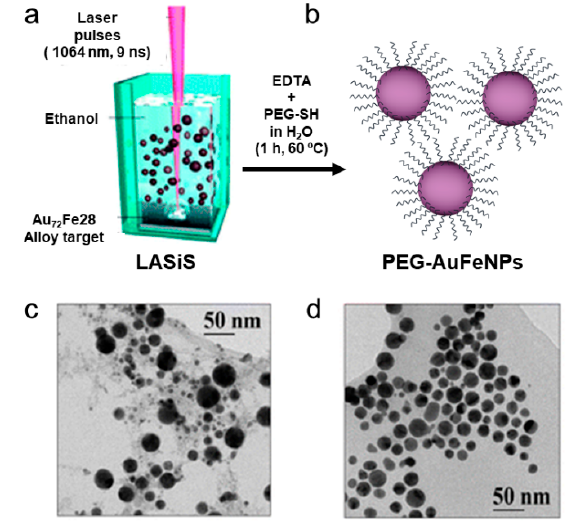
Figure 8. Two-step synthesis of PEG–AuFe NPs. ( a ) LASiS was used to synthesize AuFeNPs in ethanol from a bulk Au 72 Fe 28 alloy. ( b ) EDTA and thiolated PEG was used to obtain water stable PEG–AuFe NPs. TEM images of ( c ) the nanoparticles obtained after LASiS and ( d ) after coating with the thiolated PEG. Reproduced with permission from ref. [78]. Copyright 2013 Royal Society of Chemistry.